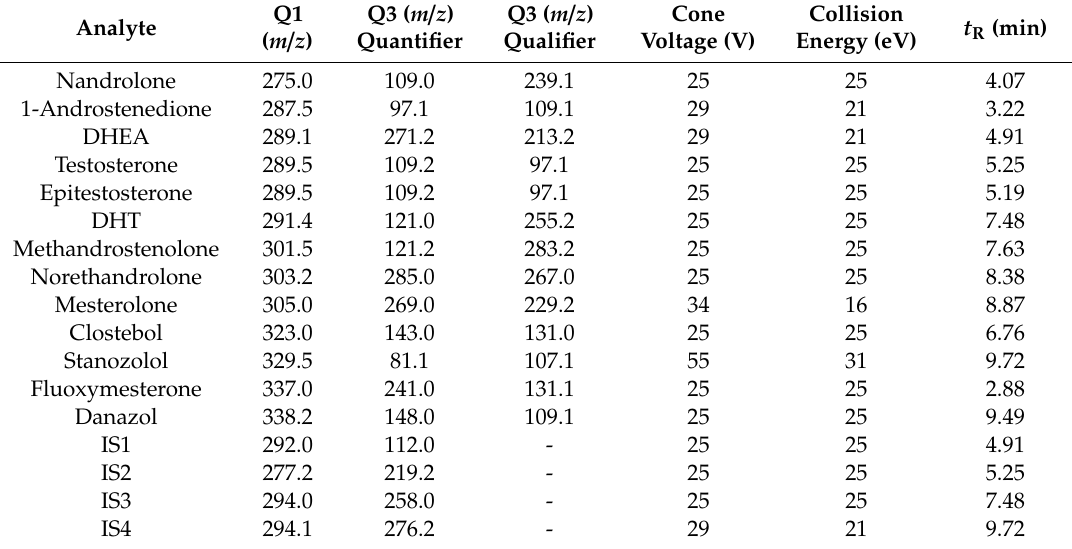
Table 8. MRM transitions, cone voltage, collision energy and retention time for each analyte and